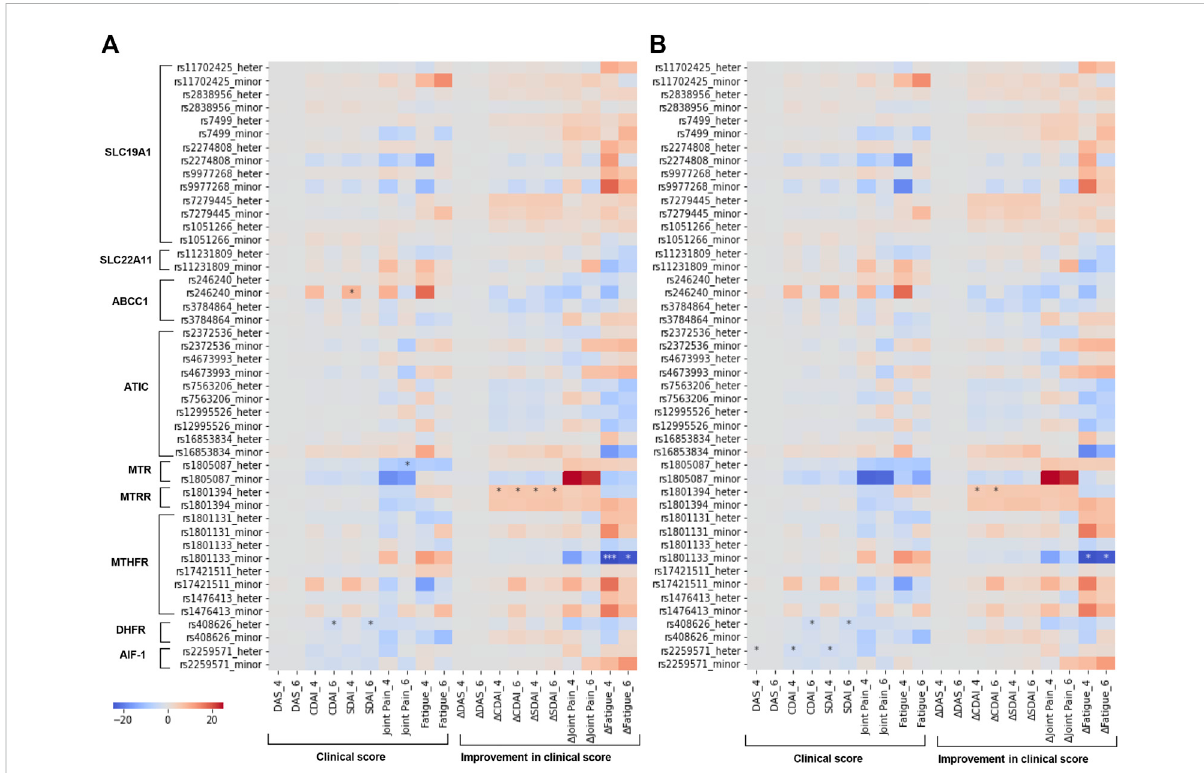
FIGURE 5 Identifying associated SNPs with continuous clinical outcomes by linear regression. Heatmap showing the association between SNPs involved in MTX metabolism and continuous clinical outcomes by linear regression with ordinary least squares regression (OLS). Coef fi cient and p -value shown in heatmap (A,B) were respectively estimated by univariate and multivariate regression analysis with age, BMI, gender and smoking as covariates. Signi fi cance level was corrected by Bonferroni correction for multiple testing and signi fi cant associations were marked by asterisk (* p -value ≤ 0.05, *** p -value ≤ 0.001). Delta values means improvements in clinical outcomes from baseline value (baseline value – current value). DAS, Disease activity score; CDAI, Clinical Disease Activity Index; SDAI, Simpli fi ed Disease Activity